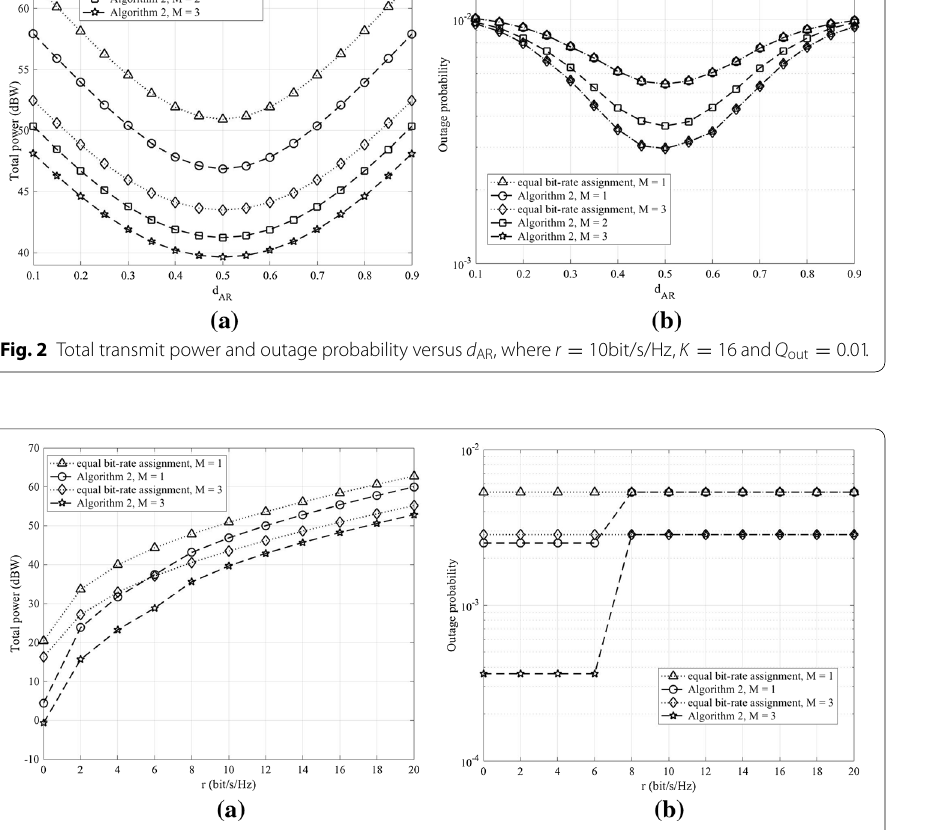
Fig. 3 Total transmit power and outage probability versus r , where d AR = 0.5 , K = 16 and Q out = 0.01